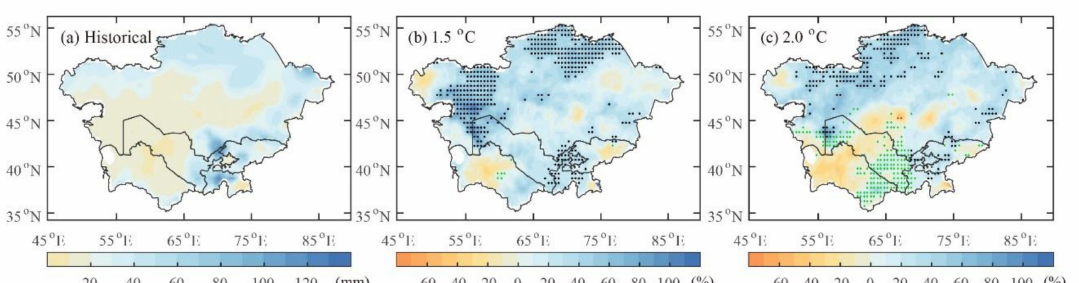
Figure 7. The spatial distribution of the very wet days (R95P) in the reference period (1986–2005) ( a ) and the di ff erence under 1.5 ◦ C ( b ) and 2 ◦ C ( c ) global warming relative to the reference period. Dark gray dots indicate that the increasing trends are significant at the 1% level in these grids. Green dots indicate a decrease in PRCPTOT and an increase in